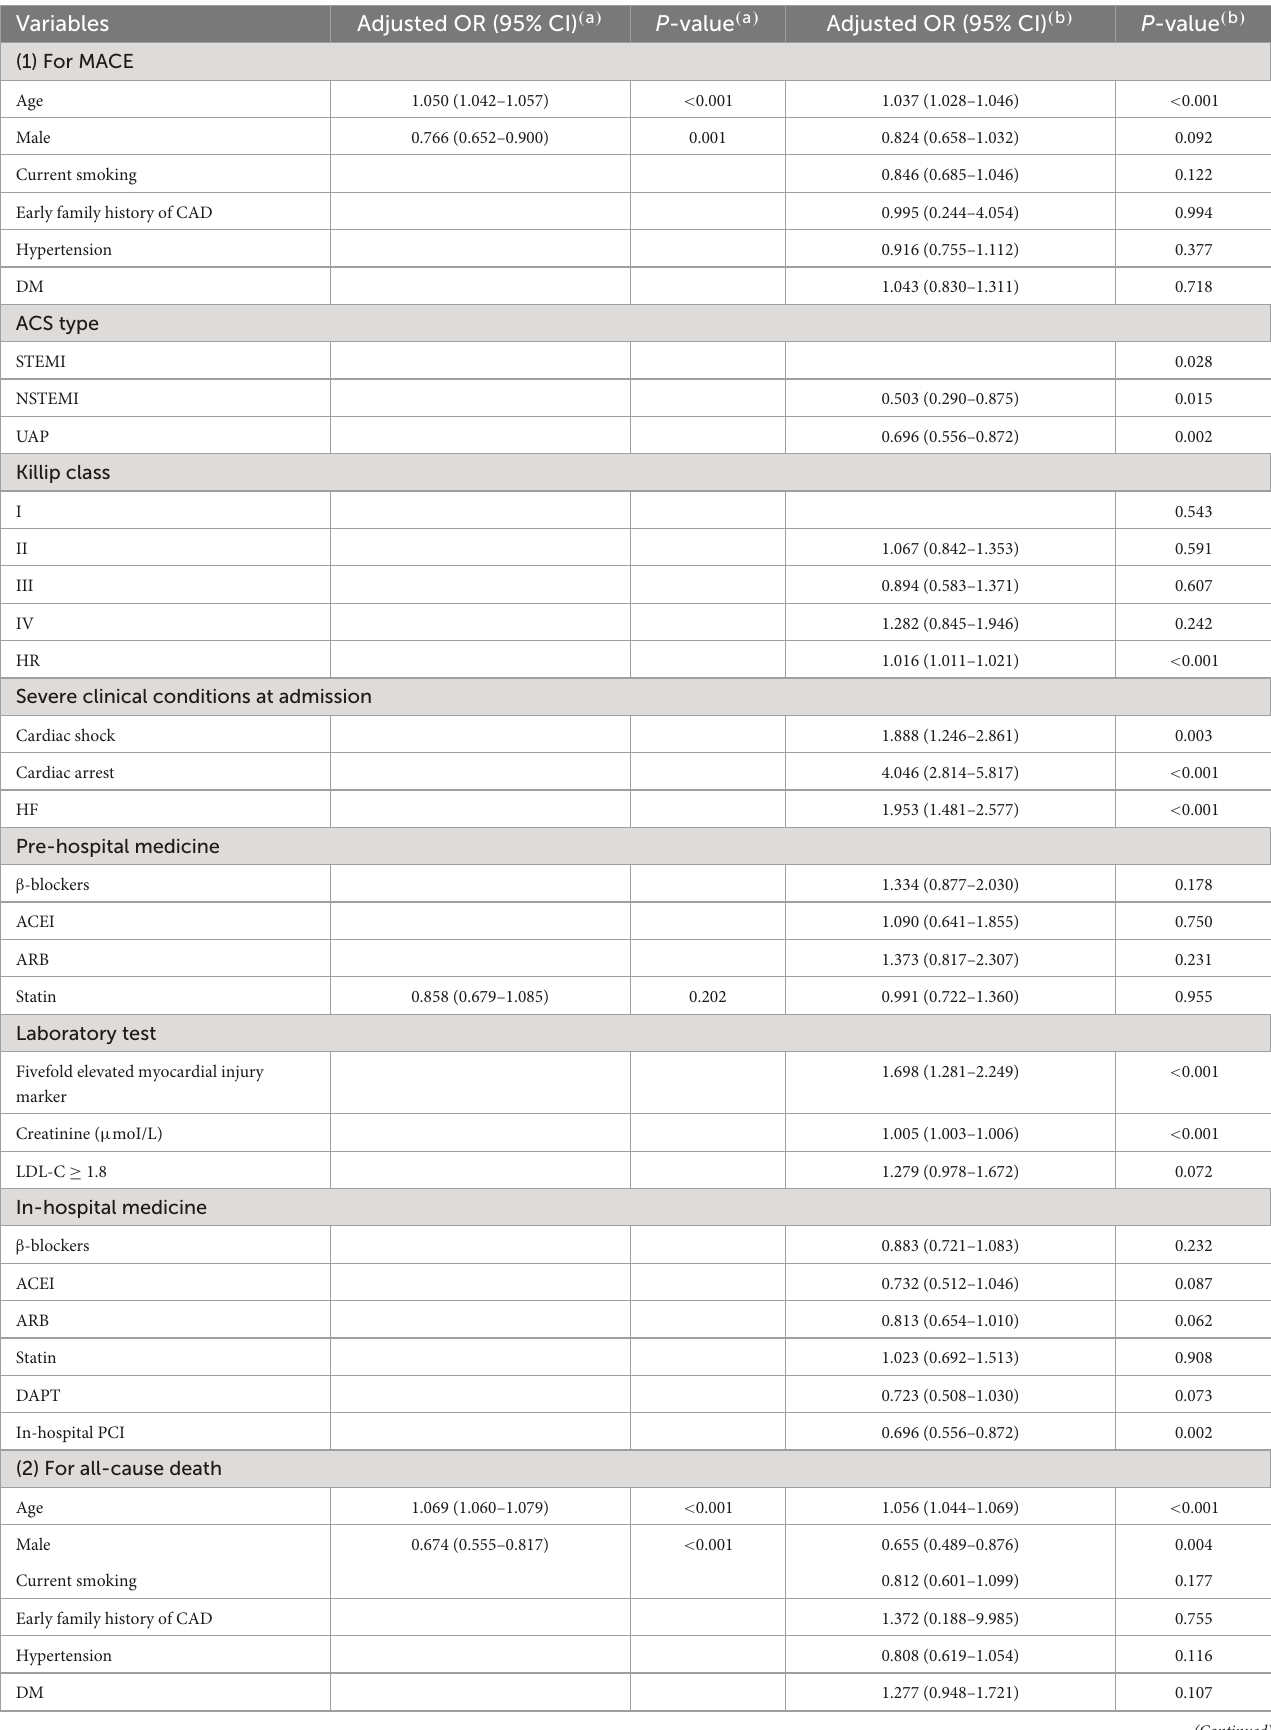
TABLE 3 Independent predictors of in-hospital MACE, all-cause death and severely obstructive CAD (CADPI ≥ 37).